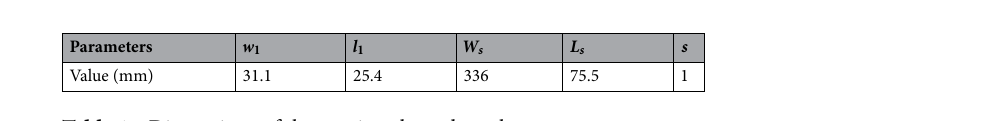
Table 1. Dimensions of the two interleaved patch array